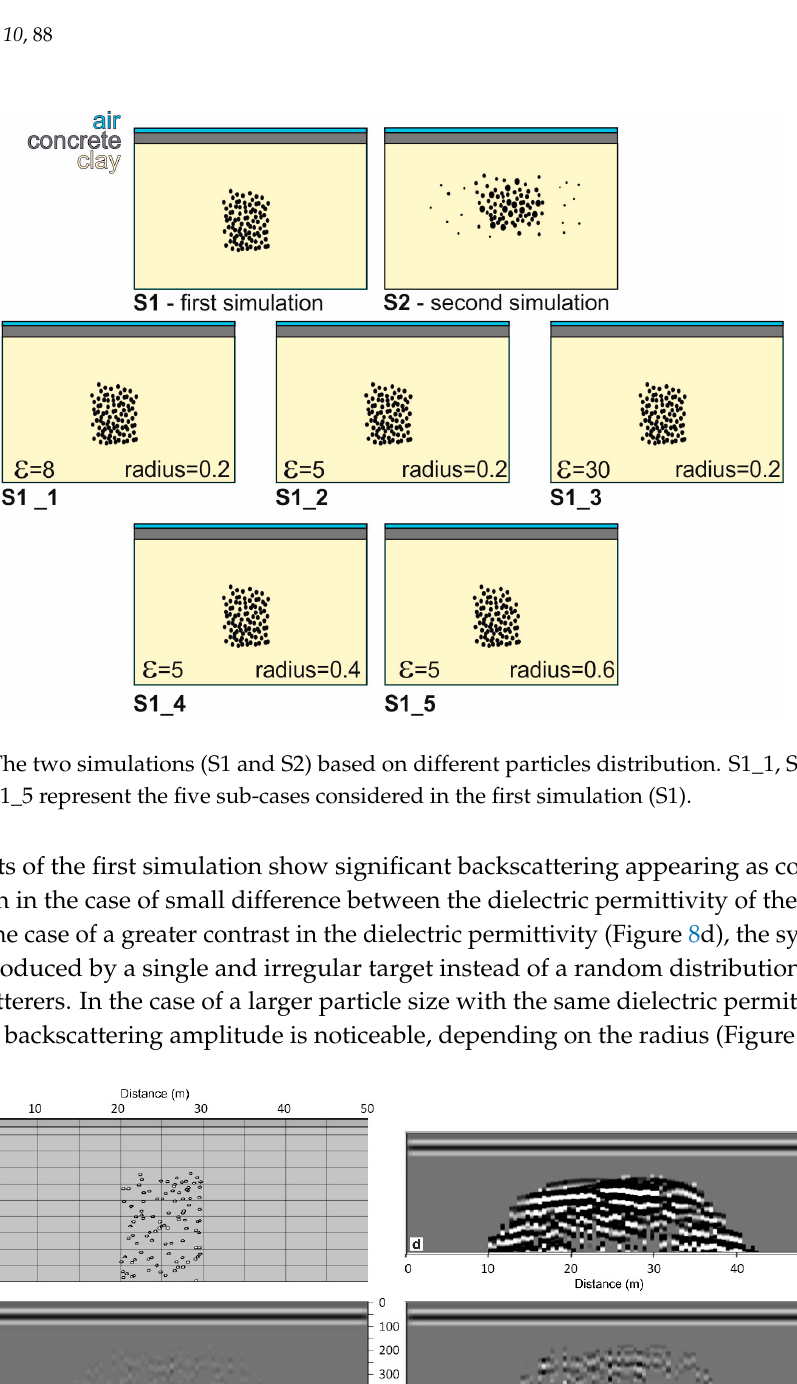
Figure 8. Three layered model with the position of the 100 scatterers ( a ) and synthetic traces for: case S1_1 ( b ); case S1_2 ( c ); case S1_3 ( d ); case S1_4 ( e ) and, case S1_5 ( f ).